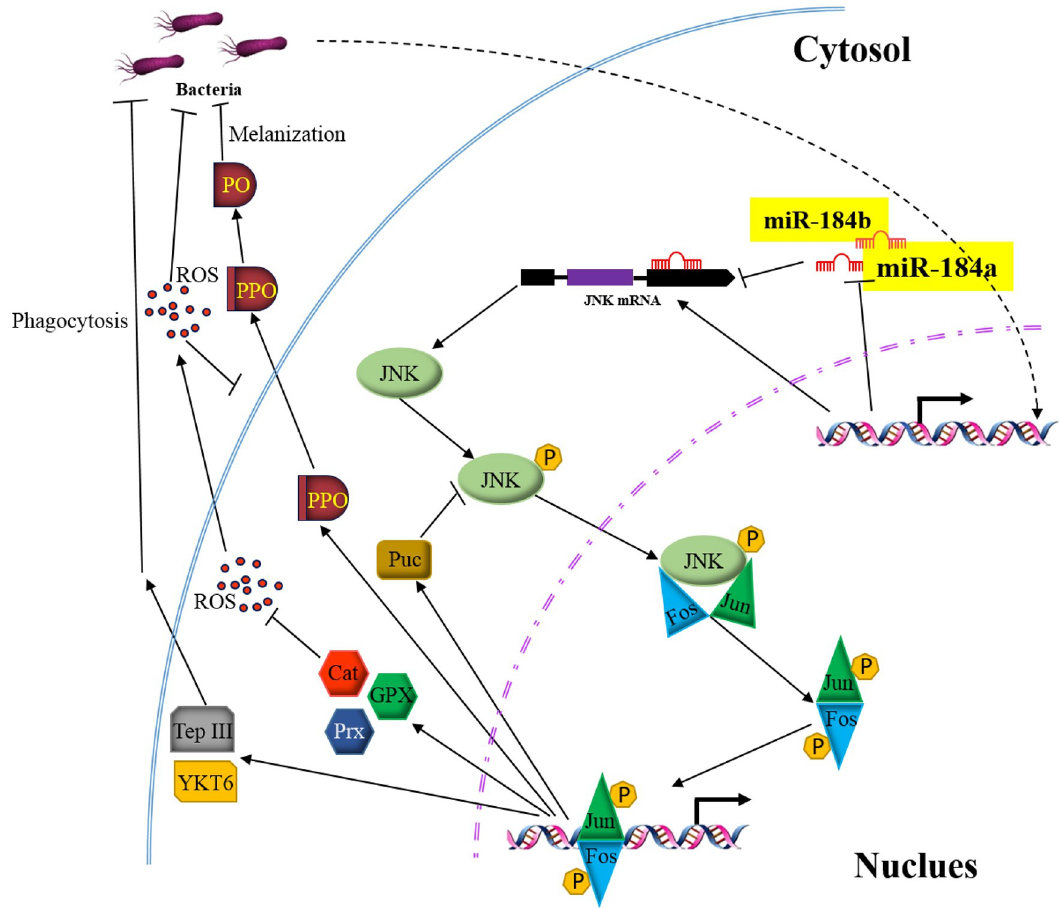
Fig 8. A schematic summary of the role of JNK pathway that modulates pea aphid immune signaling and is negatively regulated by miR-184. The transcription factor AP-1 is activated through Jun and Fos that are phosphorylated by JNK. AP-1 upregulates PO activity, increases hemocytes phagocytosis, and upregulates genes expression for ROS detoxification. JNK expression is negatively regulated by miRNA-184a/b. Bacterial infection downregulates synthesis of miRNA-184, leading to deliverance of JNK pathway and activation of immune responses consequently, to protect pea aphid from infection and oxidative